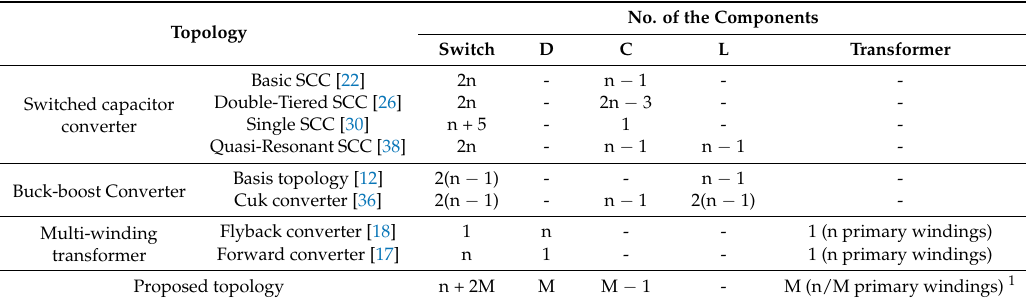
Table 3. Comparison of the proposed and conventional topologies in a number of